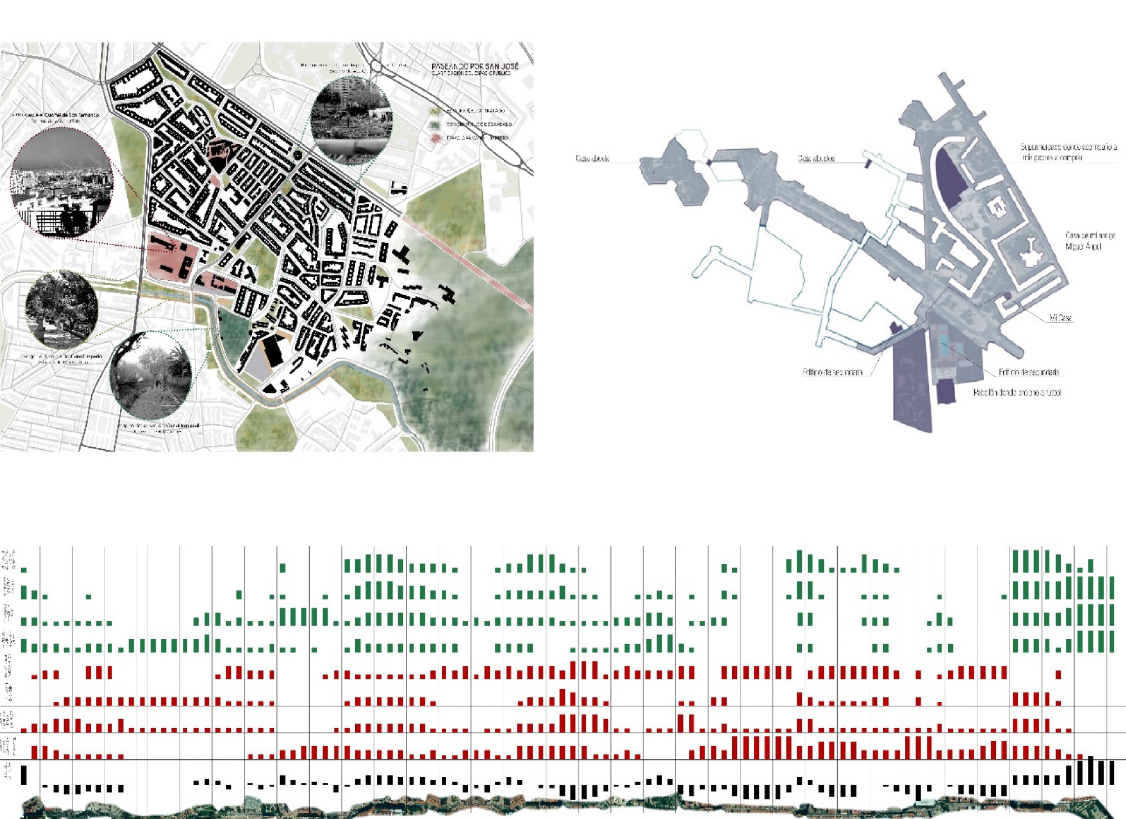
Figure 2. Intimate maps of San José, Zaragoza. (Students: N. Julian, A. Bes & S.